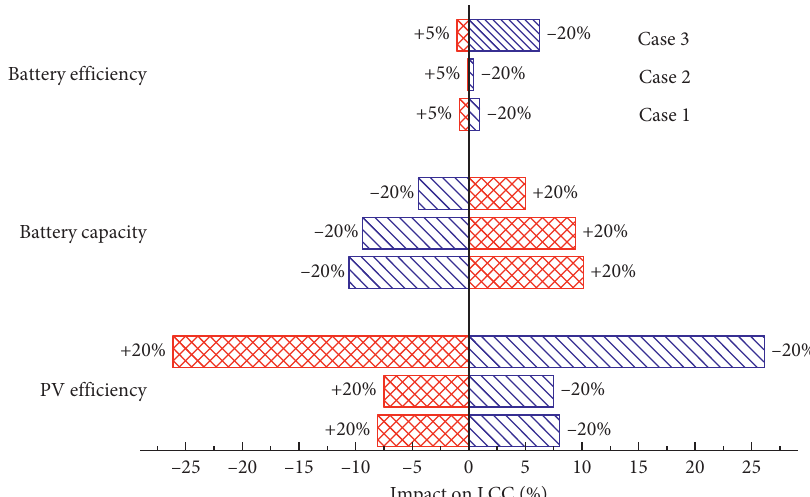
Figure 6: Sensitivity analysis considering technical aspects of three cases.